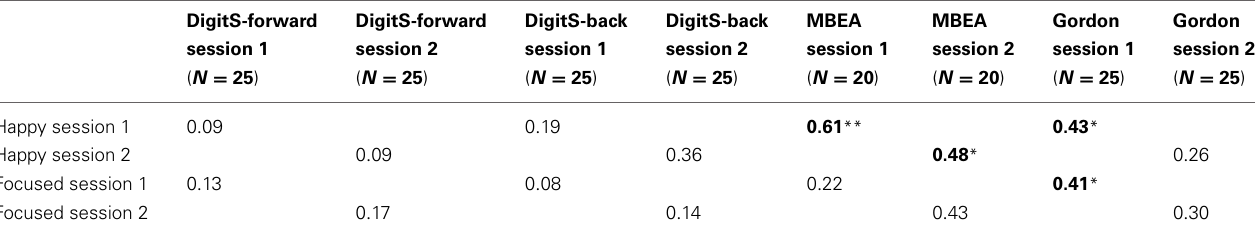
Table 6B | Spearman’s rank-order correlations between verbal and music memory tests and scores on scales of Happy and Concentrated in Group VP (first session = vasopressin, second session = placebo).